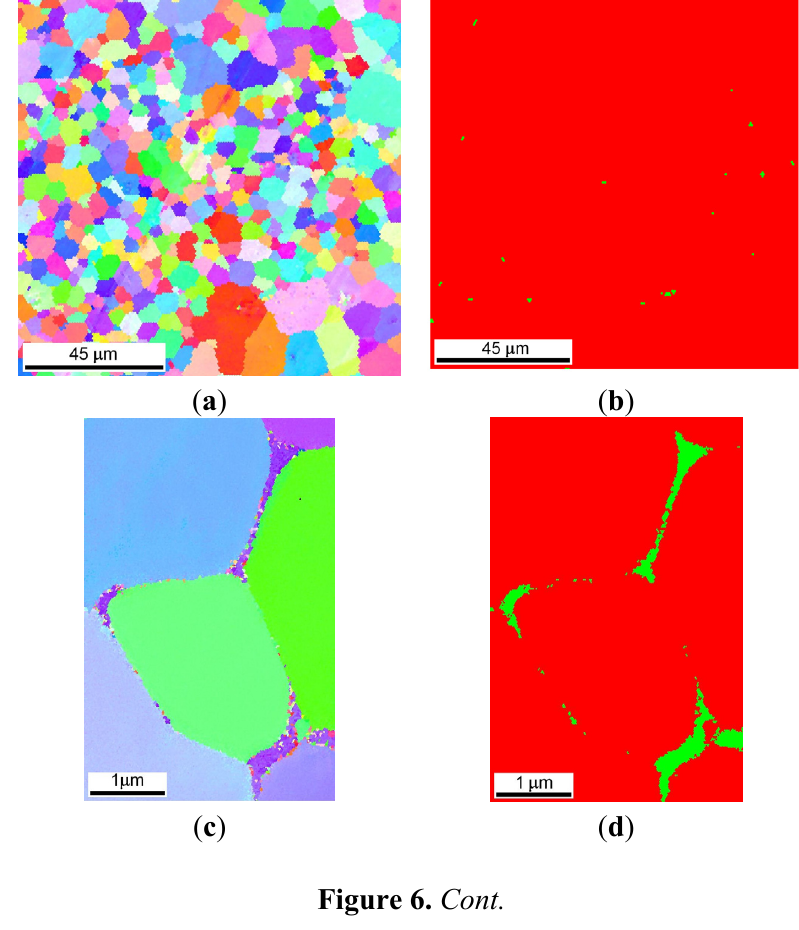
Figure 5. Isothermal sections of the Fe-Al-Ti system at 1000 °C ( a ) and 800 °C ( b ) with the compositions of the investigated alloys